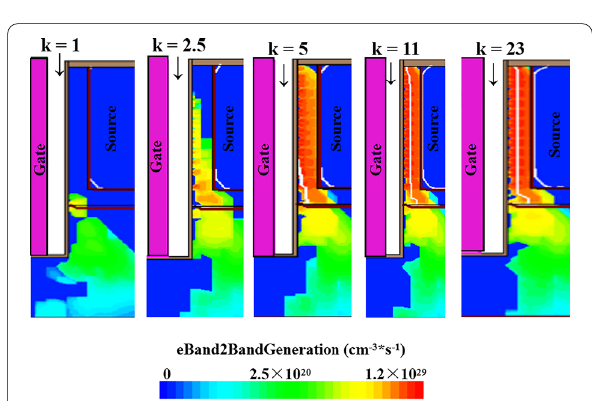
Fig.4 Electron BTBT generation in DM-DSTGTFET biosensor for different biomolecules when Vd